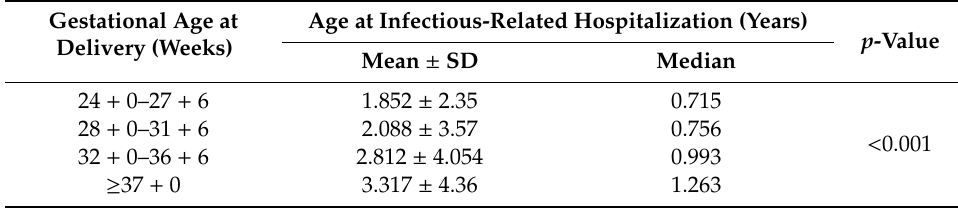
Table 3. Average at of o ff spring at the time of first infectious-related hospitalization stratified by severity of prematurity at